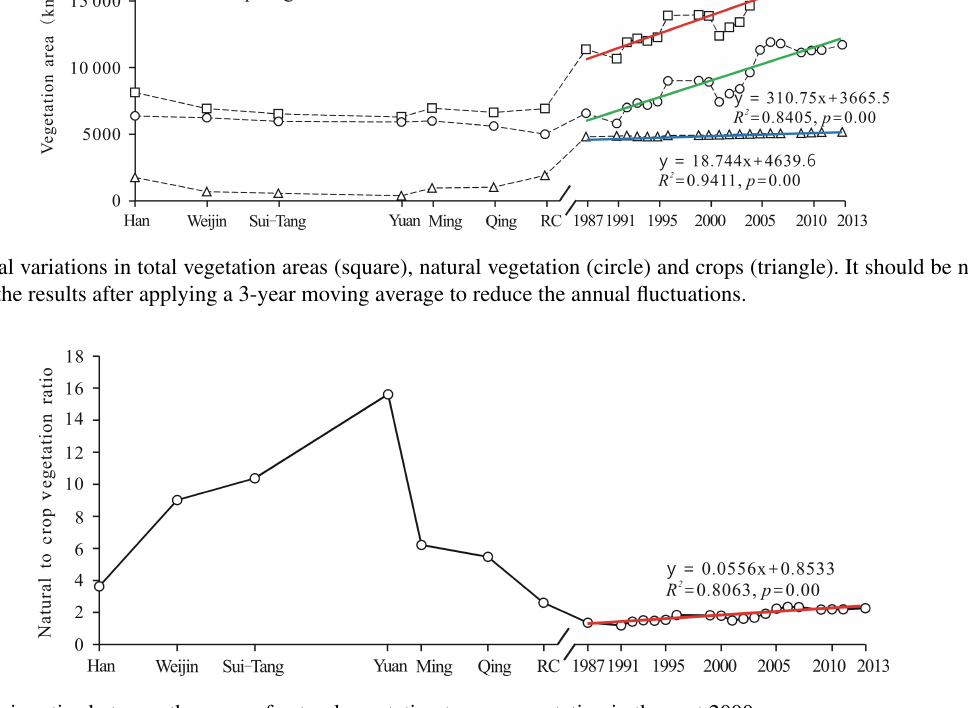
Figure 5. Changes in ratios between the areas of natural vegetation to crop vegetation in the past 2000